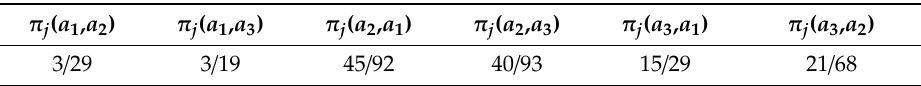
Table 4. Priority index.